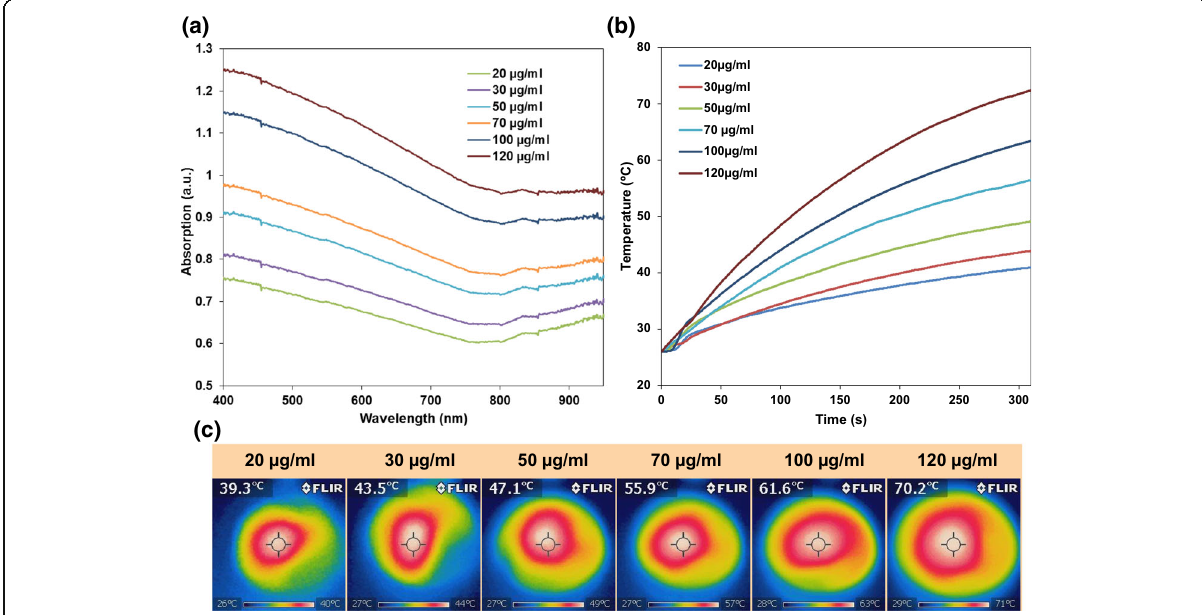
Fig. 5 a UV-Vis-NIR spectra of different concentrations of FePt@PPy NPs. b The photothermal decay of FePt@PPy NPs with different concentrations. c The corresponding NIR thermographic images of irradiated samples. All solutions were irradiated with a 1-W/cm 2 808-nm laser for 5